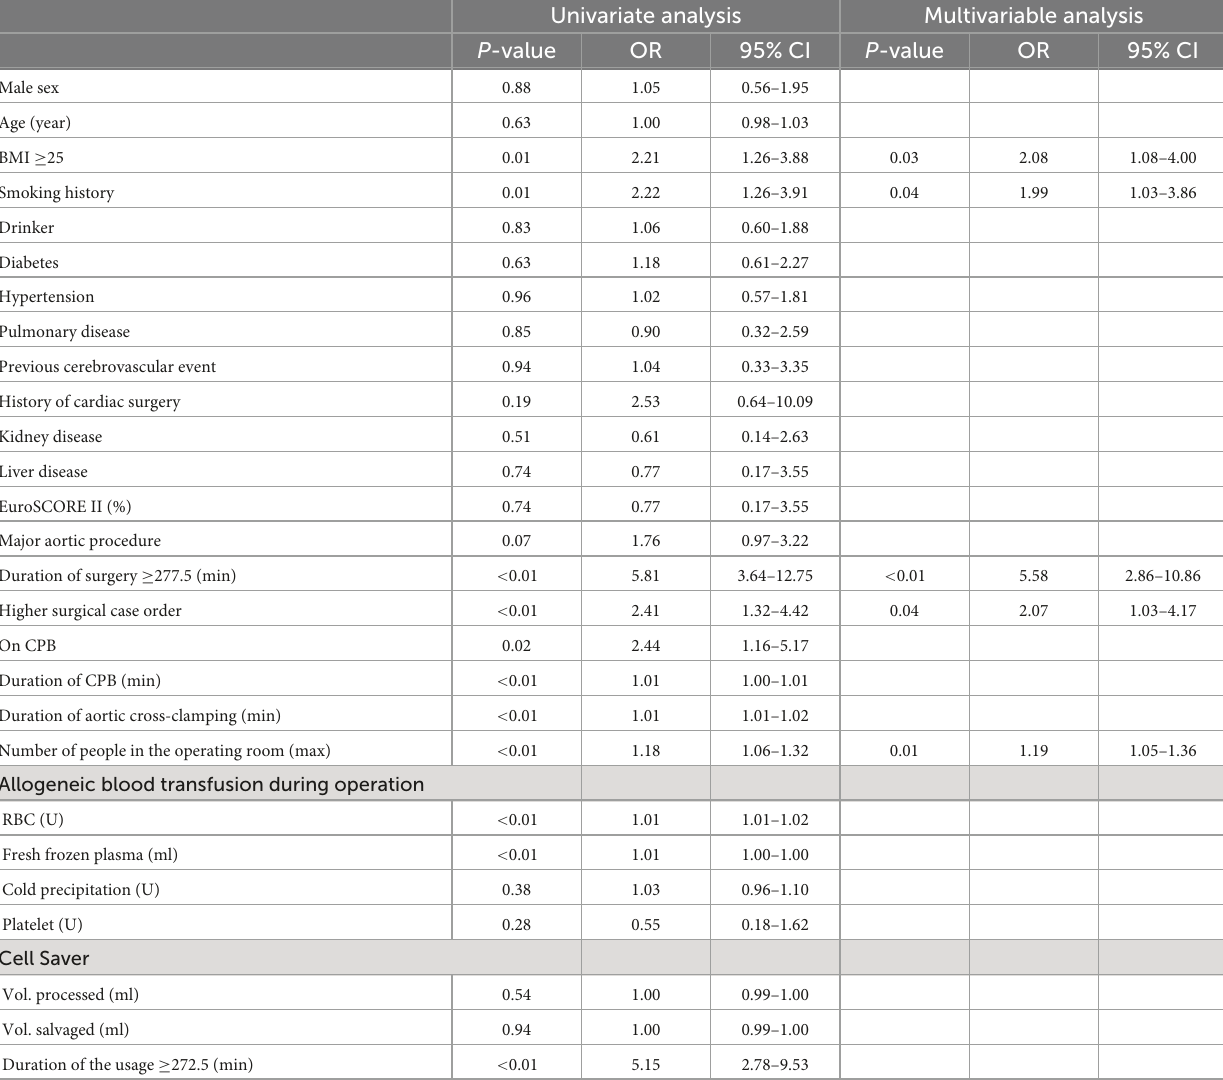
TABLE 2 Univariable analyses and multivariable models for independent factors associated with positive bacterial culture in